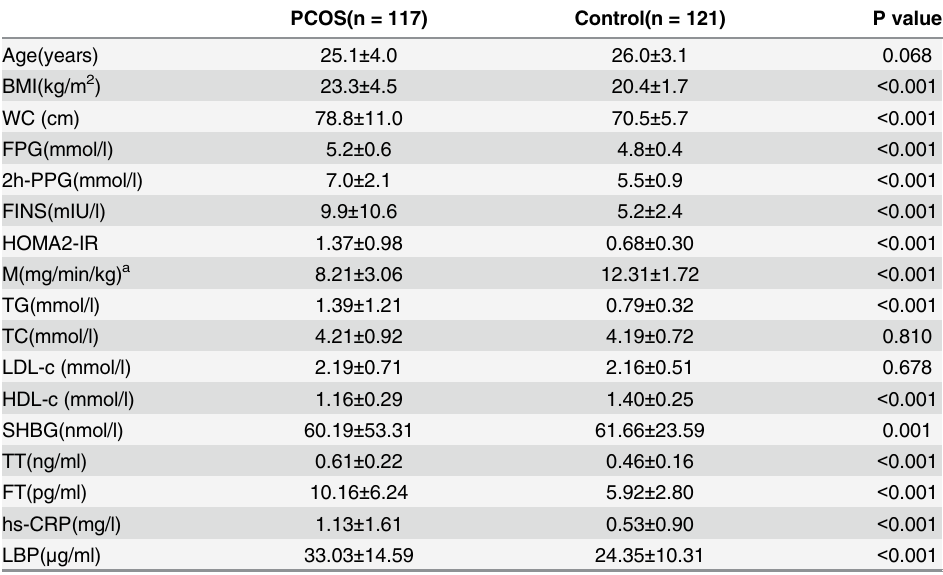
Table 1. Characteristics of subjects.